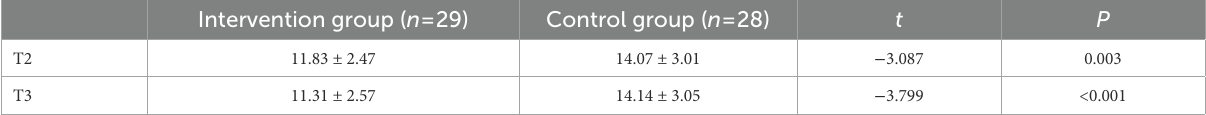
TABLE 7 Comparison of negative coping score among the intervention group and control group after